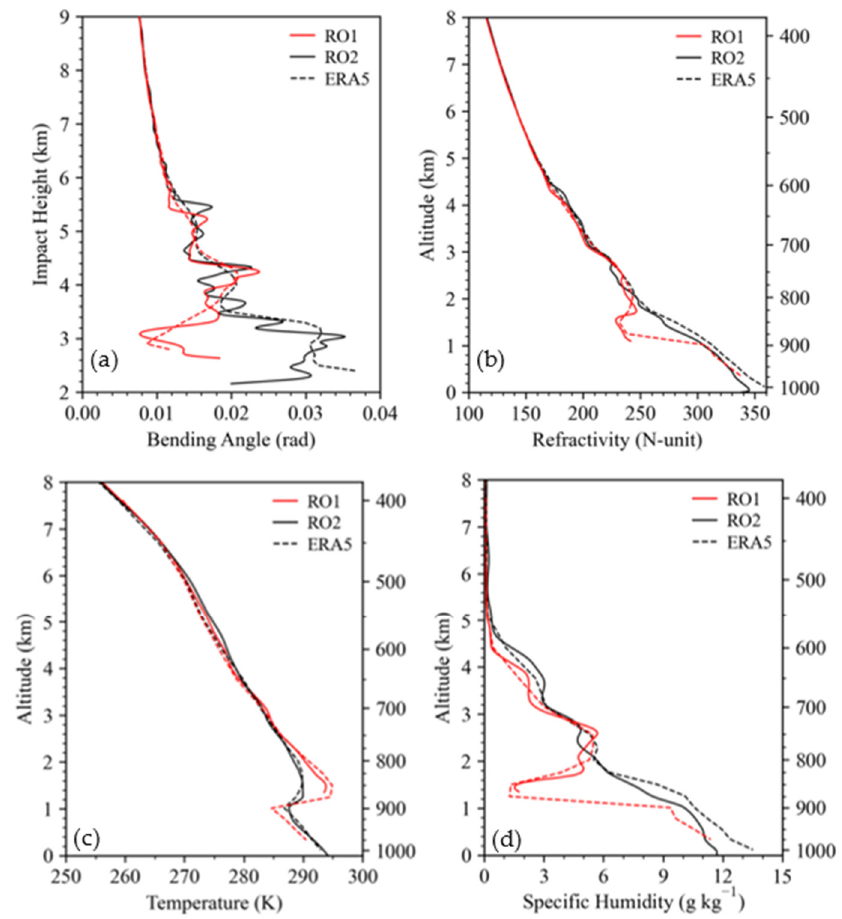
Figure 3. Vertical profiles of ( a ) bending angle, ( b ) refractivity, ( c ) temperature and ( d ) specific humidity from COSMIC-2 RO observations (solid) and the ERA5 reanalysis (dashed) for the RO1 and RO2 profiles, which are located at (6.47°S, 91.81°W) and (3.61°S, 98.99°W) in the SEP area and observed at 0637 UTC and 0719 UTC 11 August 2020, respectively.